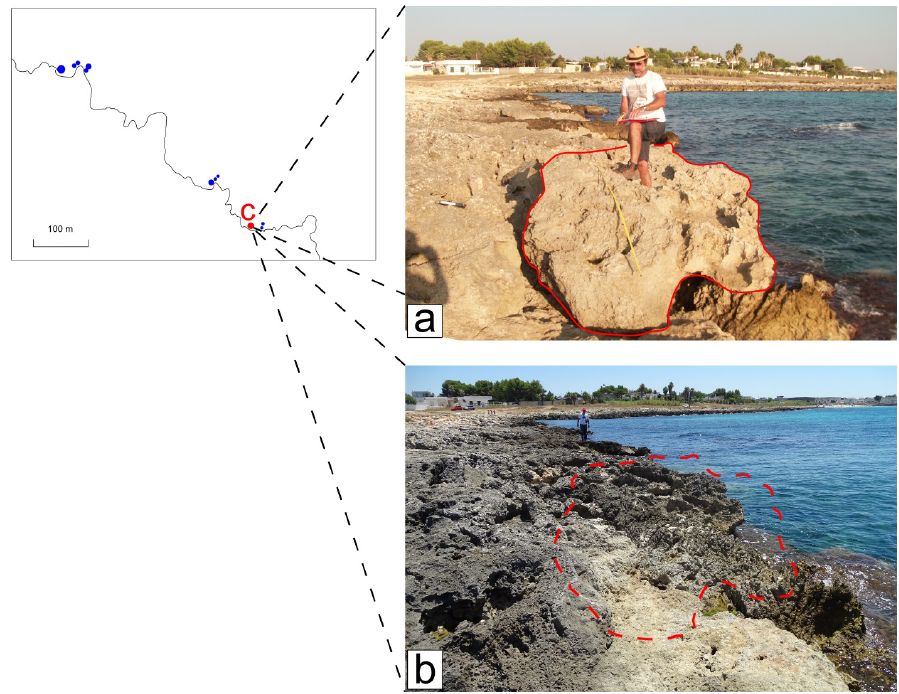
Figure 8. Pre- and post-storm event states: ( a ) photo taken before the storm; Boulder c is marked by the continuous line; ( b ) photo taken after the storm; the pre-storm position is marked by the dashed line.